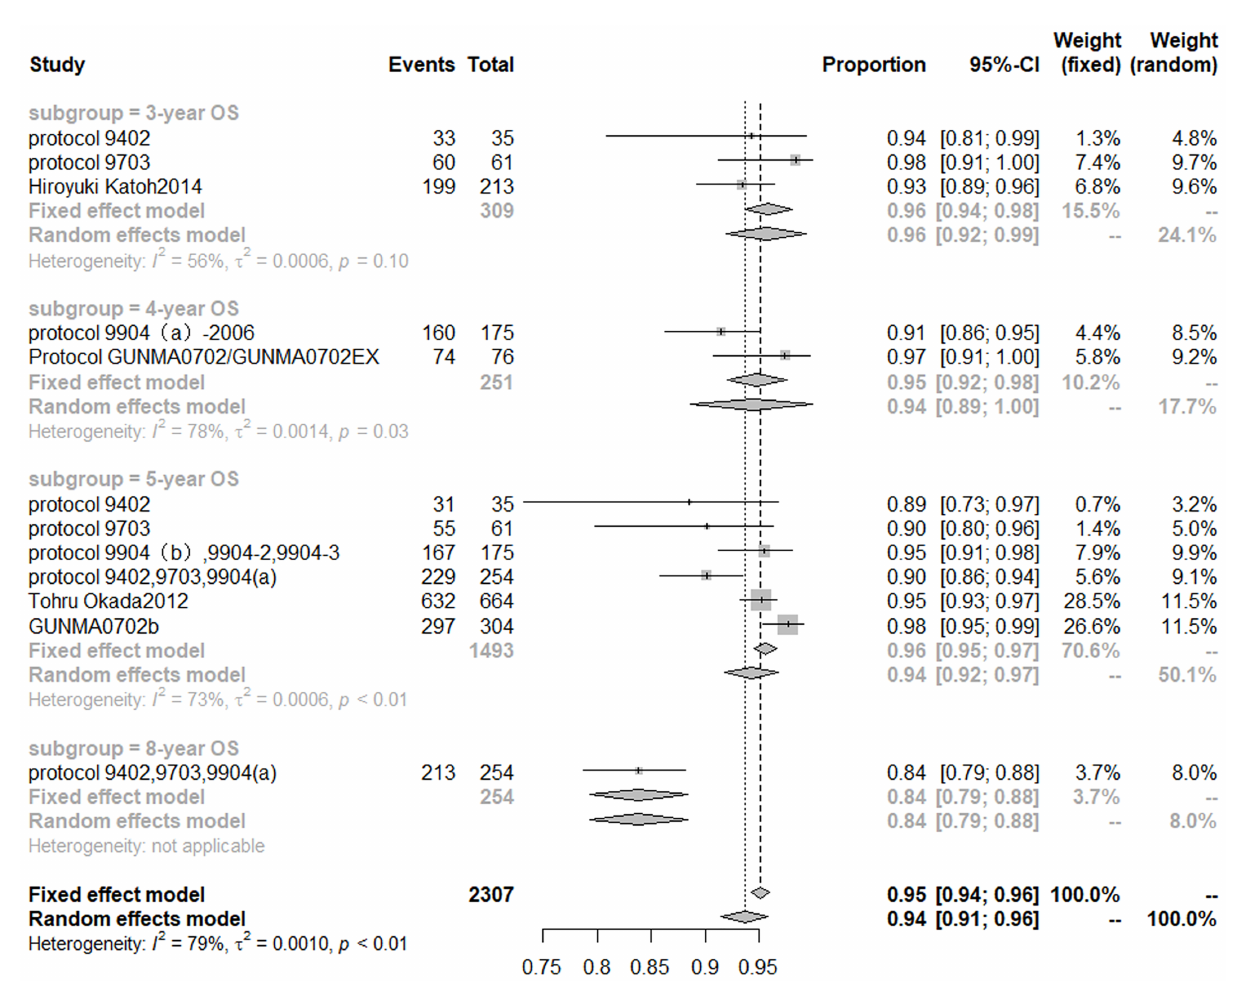
FIGURE 3 | Overall survival rate of carbon ion radiotherapy for prostate